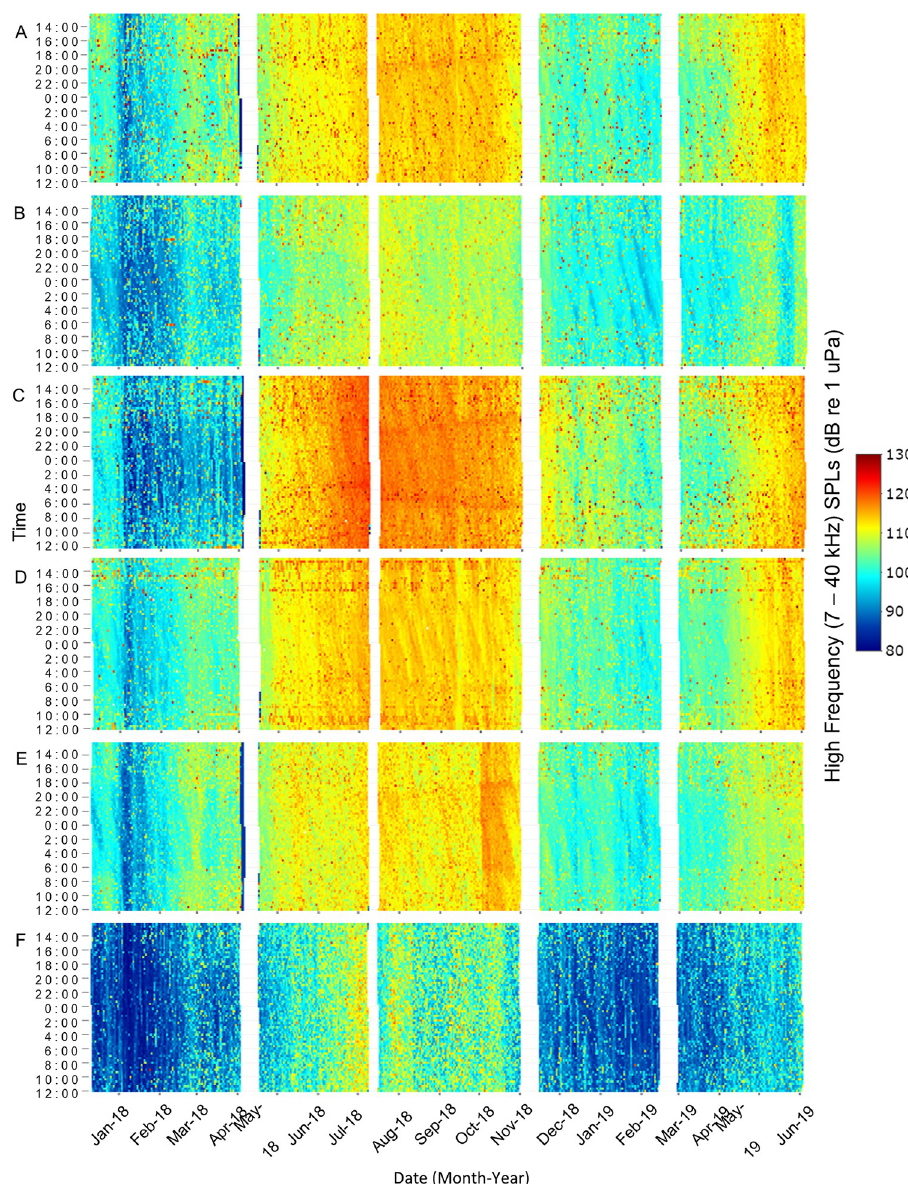
Fig 4. High frequency, sound pressure level heat map. Spatial and temporal patterns of high frequency received sound pressure levels (7–40 kHz) at (A) Wando River, (B) Drum Island, (C) SC Aquarium, (D) Fort Sumter, (E) Ashley River, and (F) Citadel stations. Recordings were taken every 20 minutes. Time is shown between noon and noon the next day. White spaces represent gaps in the data due to maintenance of equipment between